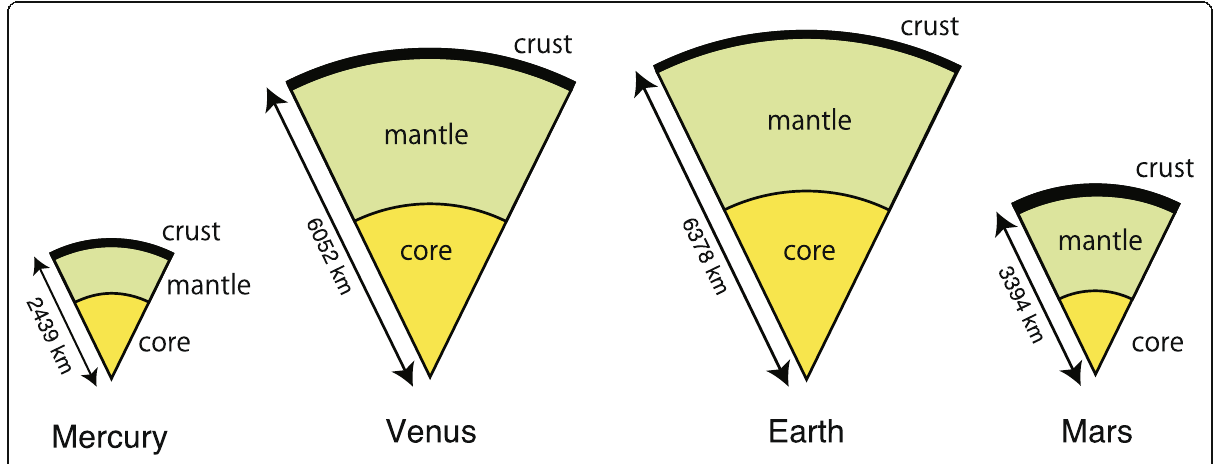
Fig. 1 Internal structure of the terrestrial planets, composed of crust, mantle, and core